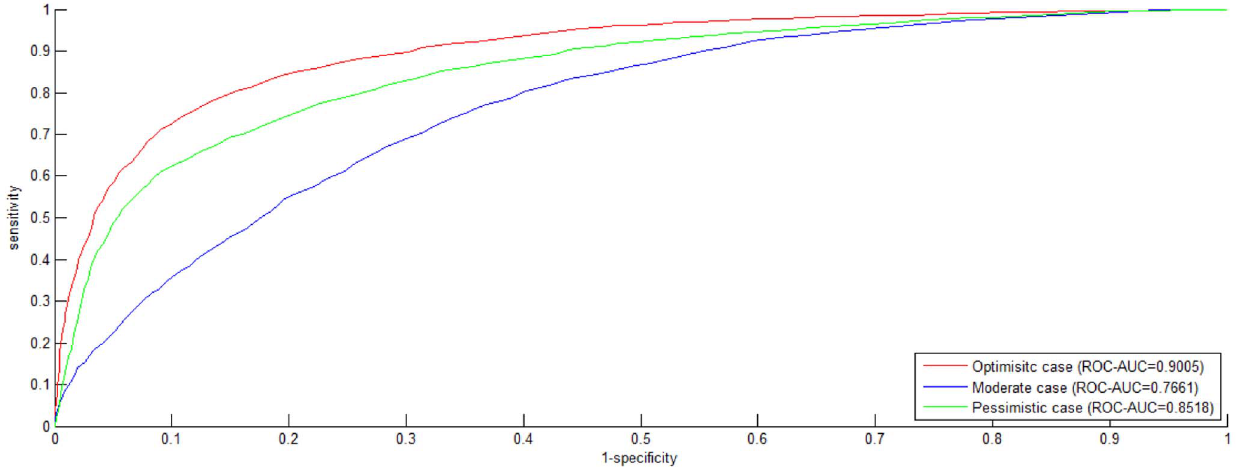
Figure 4. ROCcurve on S2 dataset. The negative data is constructed by by the negative data sampling method of random sampling . The ROC curves in red, blue and green indicate the performance for the Optimistic case, the Moderate case and the Pessimistic case, respectively.